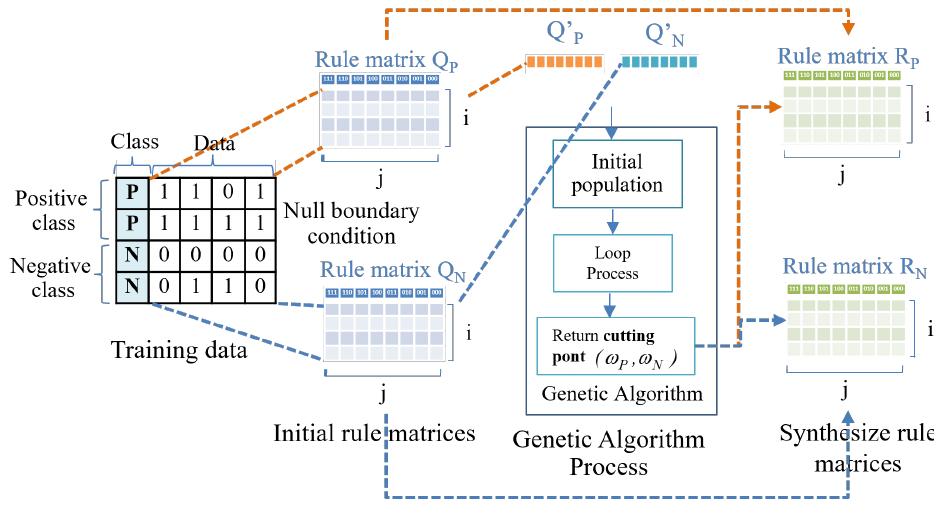
Figure 1. CAC rule